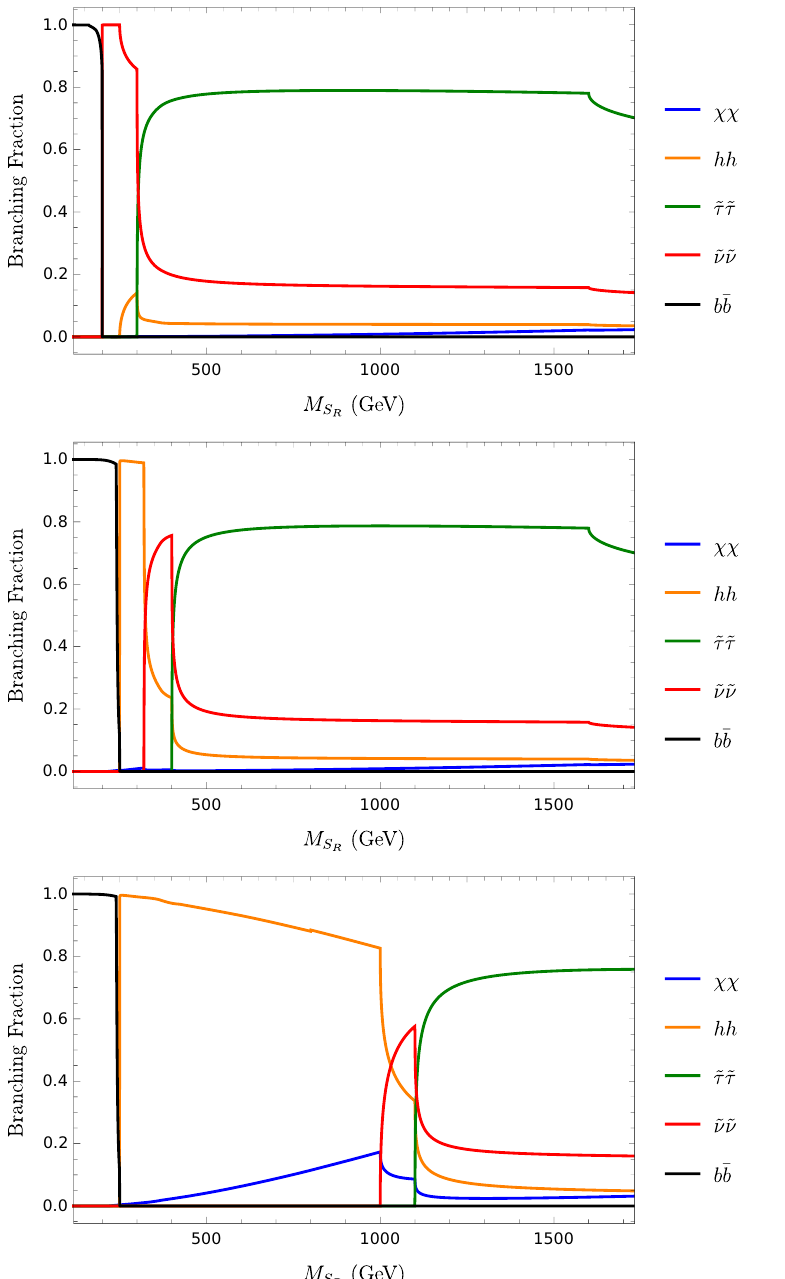
Figure 6 . Branching fractions for decay of the scalar singlet in (top) benchmark B1, (middle) benchmark B2, and (bottom) benchmark